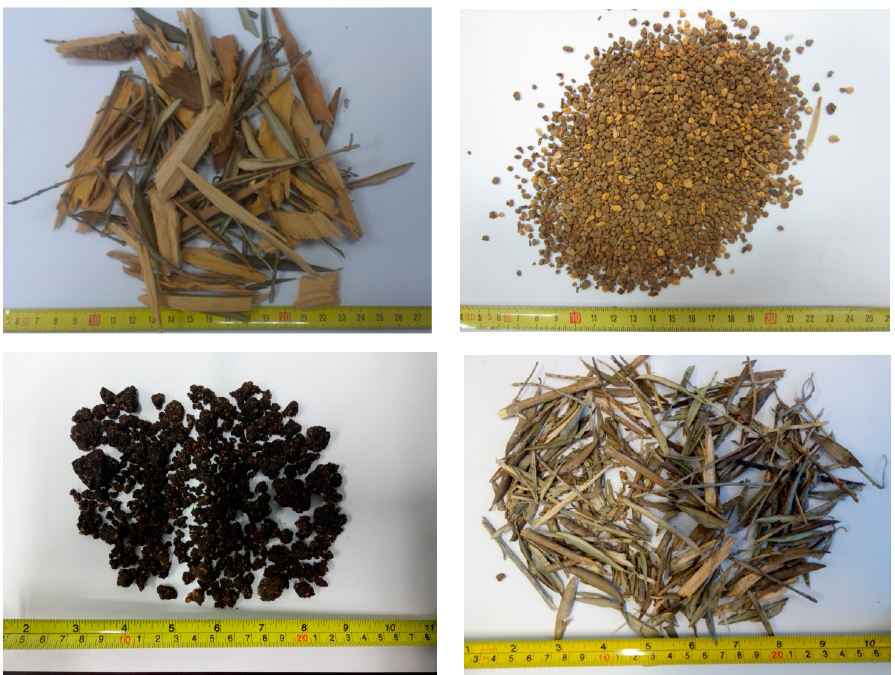
Figure 2. Sample of olive tree pruning ( top-left ), olive pits ( top-right ), dry olive pomace ( bottom-left ) and leaves and twigs ( bottom-right ).